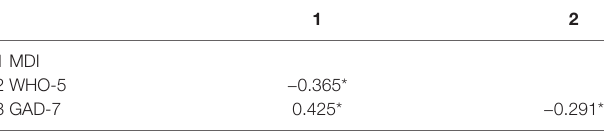
TABLE 3 | Correlation coefficients between the WHO-5, GAD-7, and